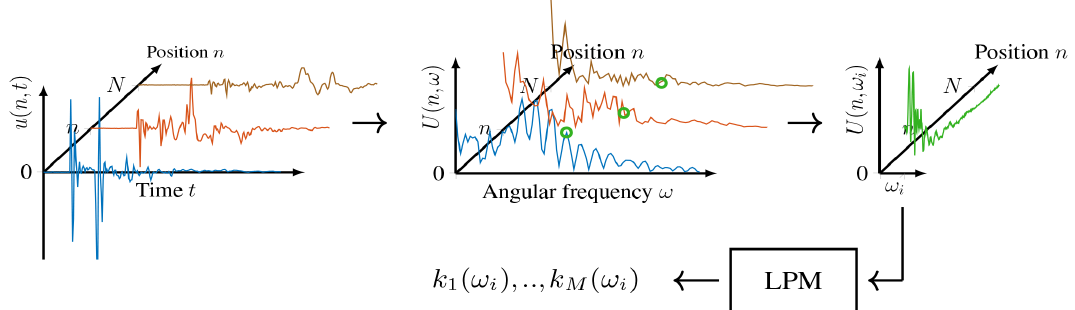
Figure 11. Concept of the application of the linear prediction method for the calculation of angular wavenumbers k m for a each angular frequency ω i